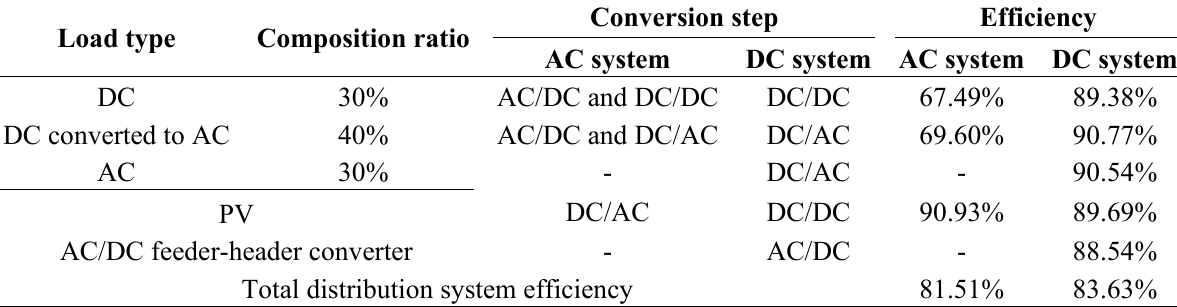
Table 1. Power conversion efficiency for each type of distribution configuration.